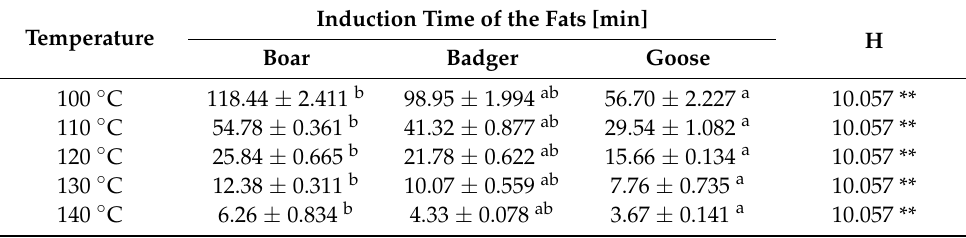
Table 3. Induction time of the boar, badger and wild goose fats (measuring temperature 100 ◦ C, 110 ◦ C, 120 ◦ C, 130 ◦ C, and 140 ◦ C).